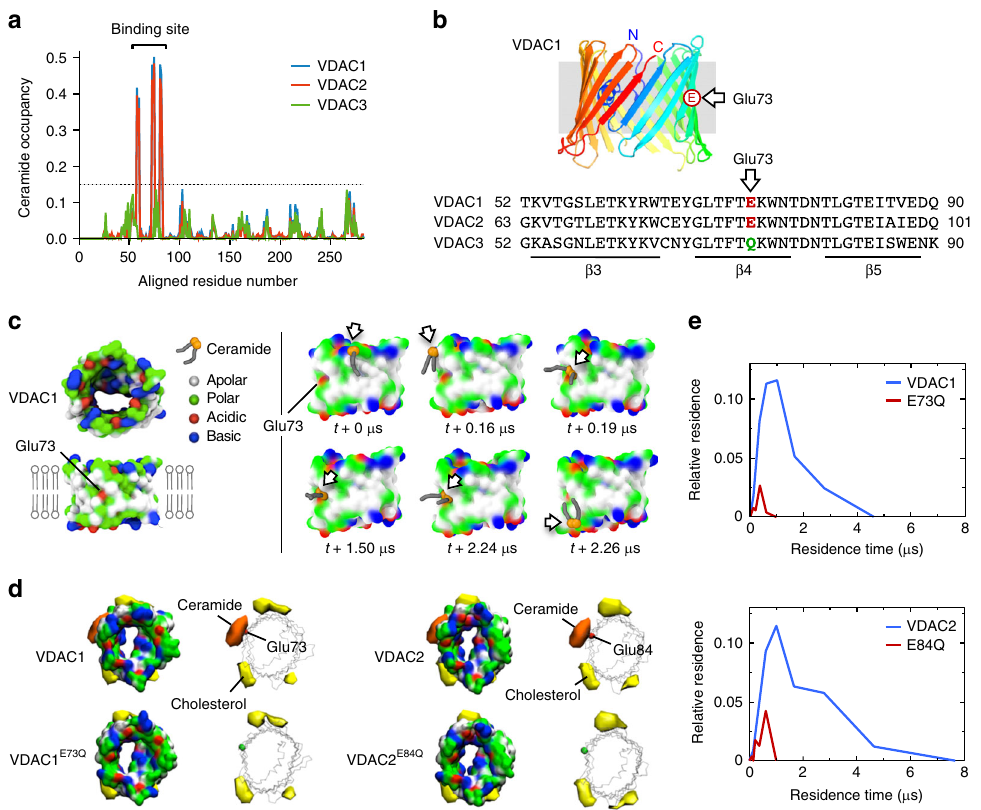
Fig. 2 MD simulations uncover a putative ceramide-binding site on VDAC1 and -2. a Ceramide head group contact occupancy of mouse VDAC1, VDAC2, and VDAC3 in an OMM model containing 5 mol% ceramide, with 1.0 corresponding to a ceramide contact during the entire simulation time. A threshold of 15% occupancy, based on the occupancies of non-binding site residues, is indicated by a dotted blue line. VDAC1 and VDAC2 have a clear ceramide- binding site, comprising residues 58 – 62, 71 – 75, and 81 – 85; this site is lacking in VDAC3. b Sequence alignment revealing the position of a bilayer-facing Glu residue in VDAC1 (E73) and VDAC2 (E84), which is replaced by Gln in VDAC3 (Q73). c Stills from an MD simulation, showing the approach and binding of a ceramide molecule to VDAC1 in close proximity of the bilayer-facing Glu residue in its deprotonated state. Protein surface colors mark polar (green), apolar (white), cationic (blue), or anionic (red) residues. d Space- fi lling and wireframe models of VDAC1, VDAC1 E73Q , VDAC2, and VDAC2 E84Q with deprotonated E73/E84. Indicated are the volumes for which there is ceramide occupancy greater than 10% (orange) or cholesterol occupancy greater than 20% (yellow). e Distribution of the durations of ceramide contacts with VDAC1, VDAC1 E73Q , VDAC2, and VDAC2 E84Q at the preferred binding site as in d . The y -axis indicates the fraction of the total system time spent in binding events of the duration indicated by x . Summing all points ’ y -values yields the fraction of total simulation time when ceramide was